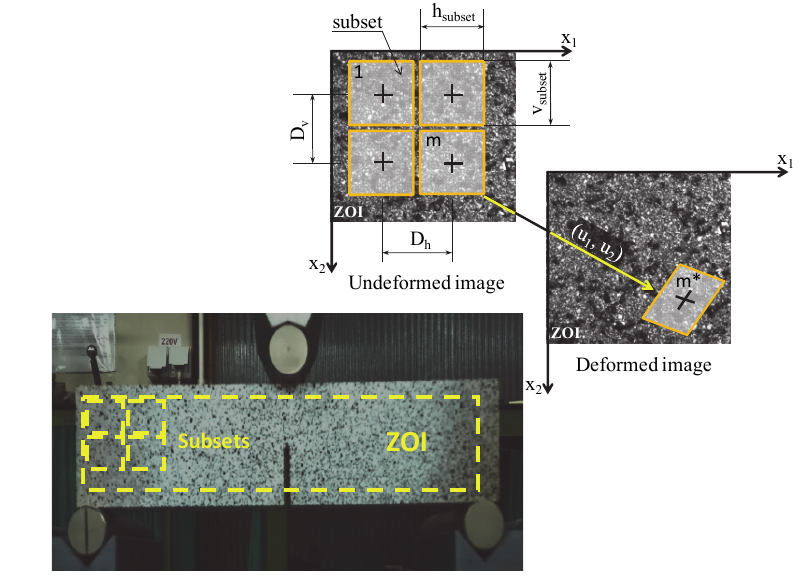
Figure 6: Principle of DIC